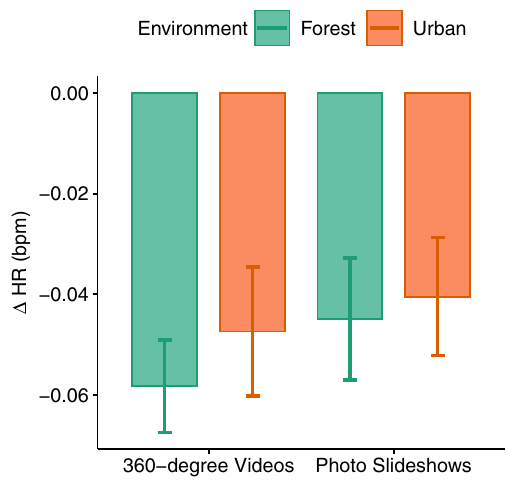
Figure 7. HR difference scores.